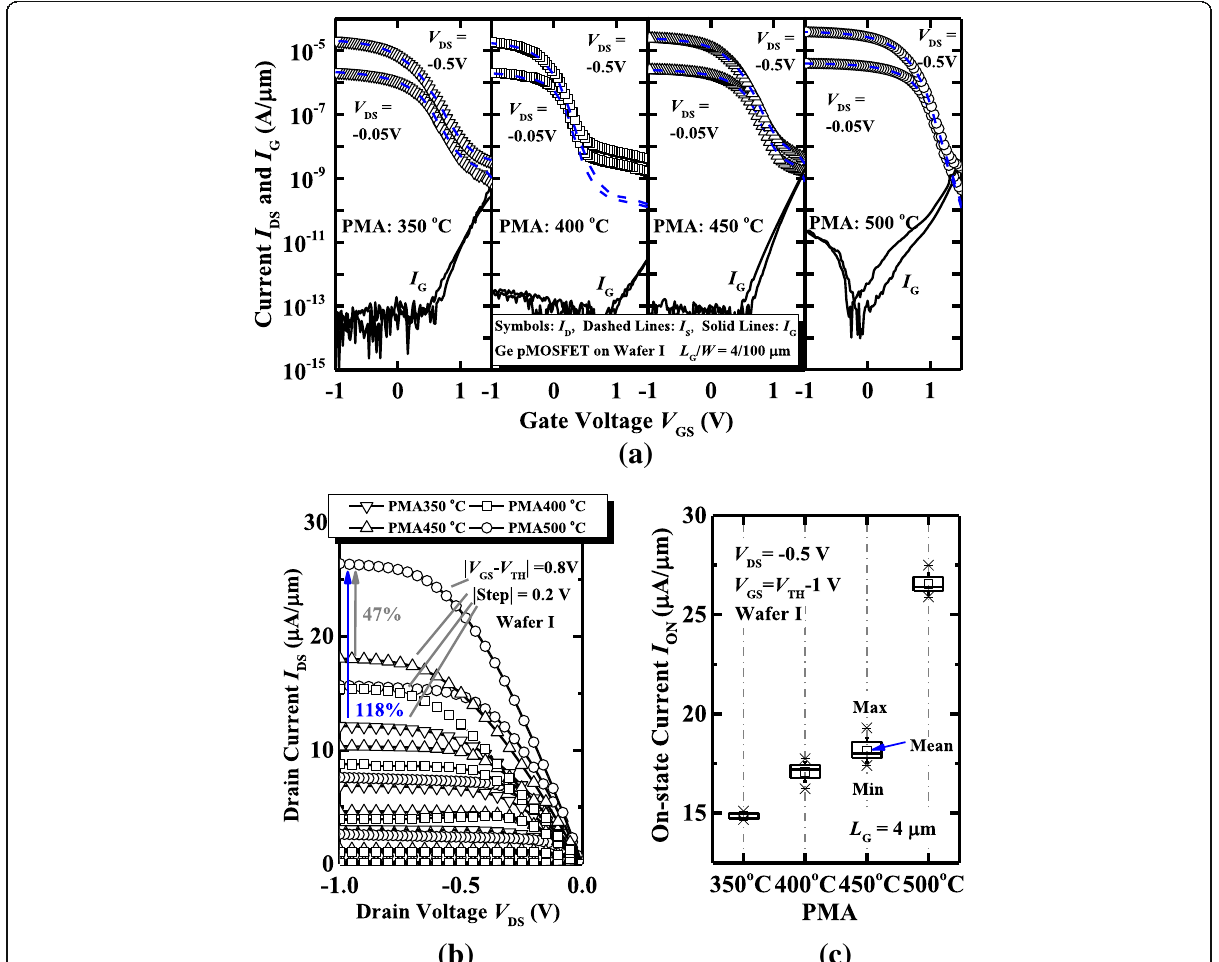
Fig. 3 a Measured I D , I S , and I G vs. V GS curves of Ge pMOSFETs on wafer I with the PMA at 350, 400, 450, and 500 °C. b I DS - V DS curves measured at the different V GS - V TH for the devices. c Device annealed at 500 °C has a higher on-state current I ON compared to the transistors with the PMA at the lower